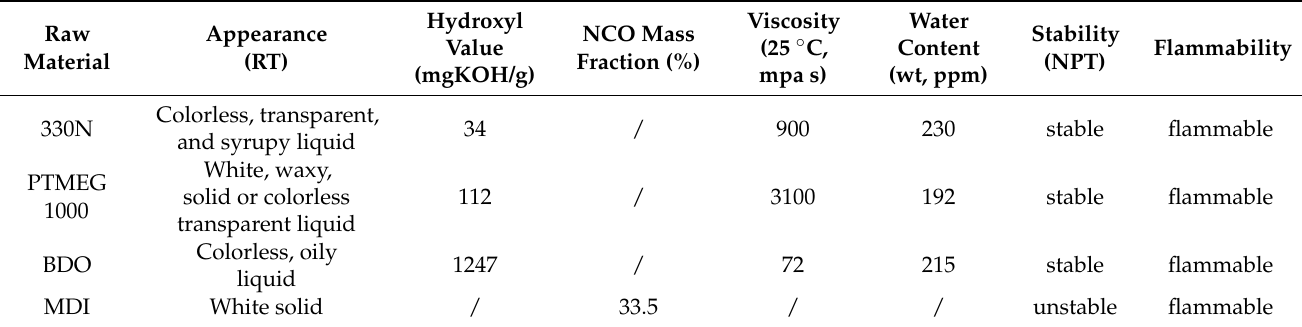
Figure 1. Chemical structure of polyether polyol 330N. Table 1. The main physical and chemical properties of the main raw materials.